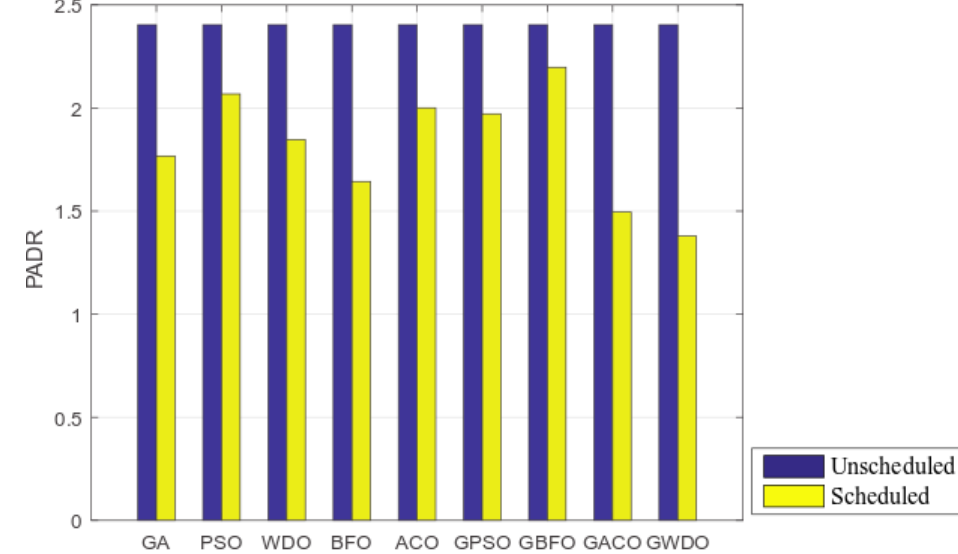
Figure 6. Case study 1: PADR